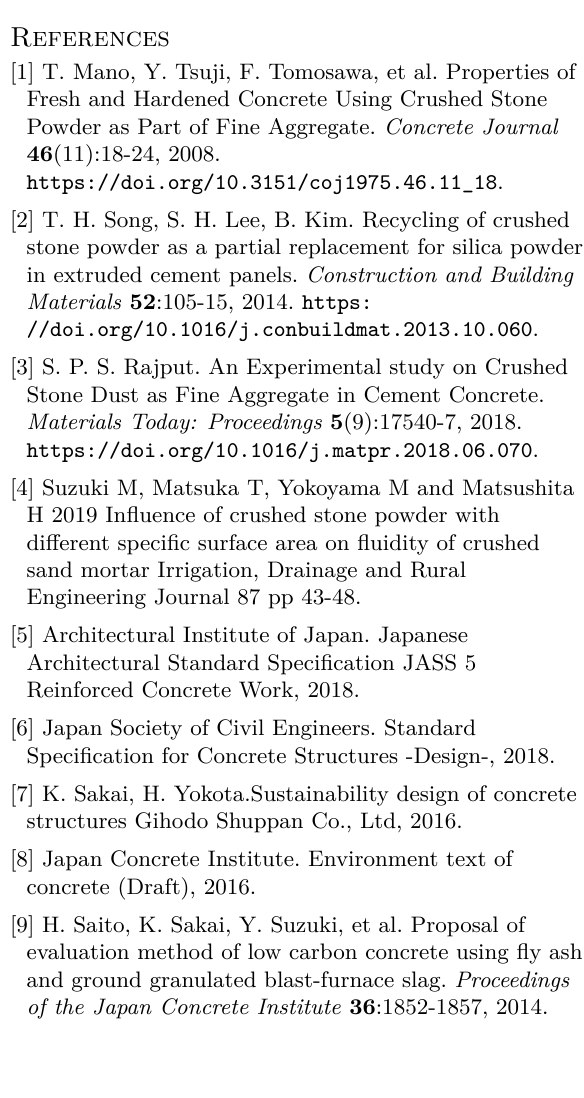
Figure 14. Sustainability